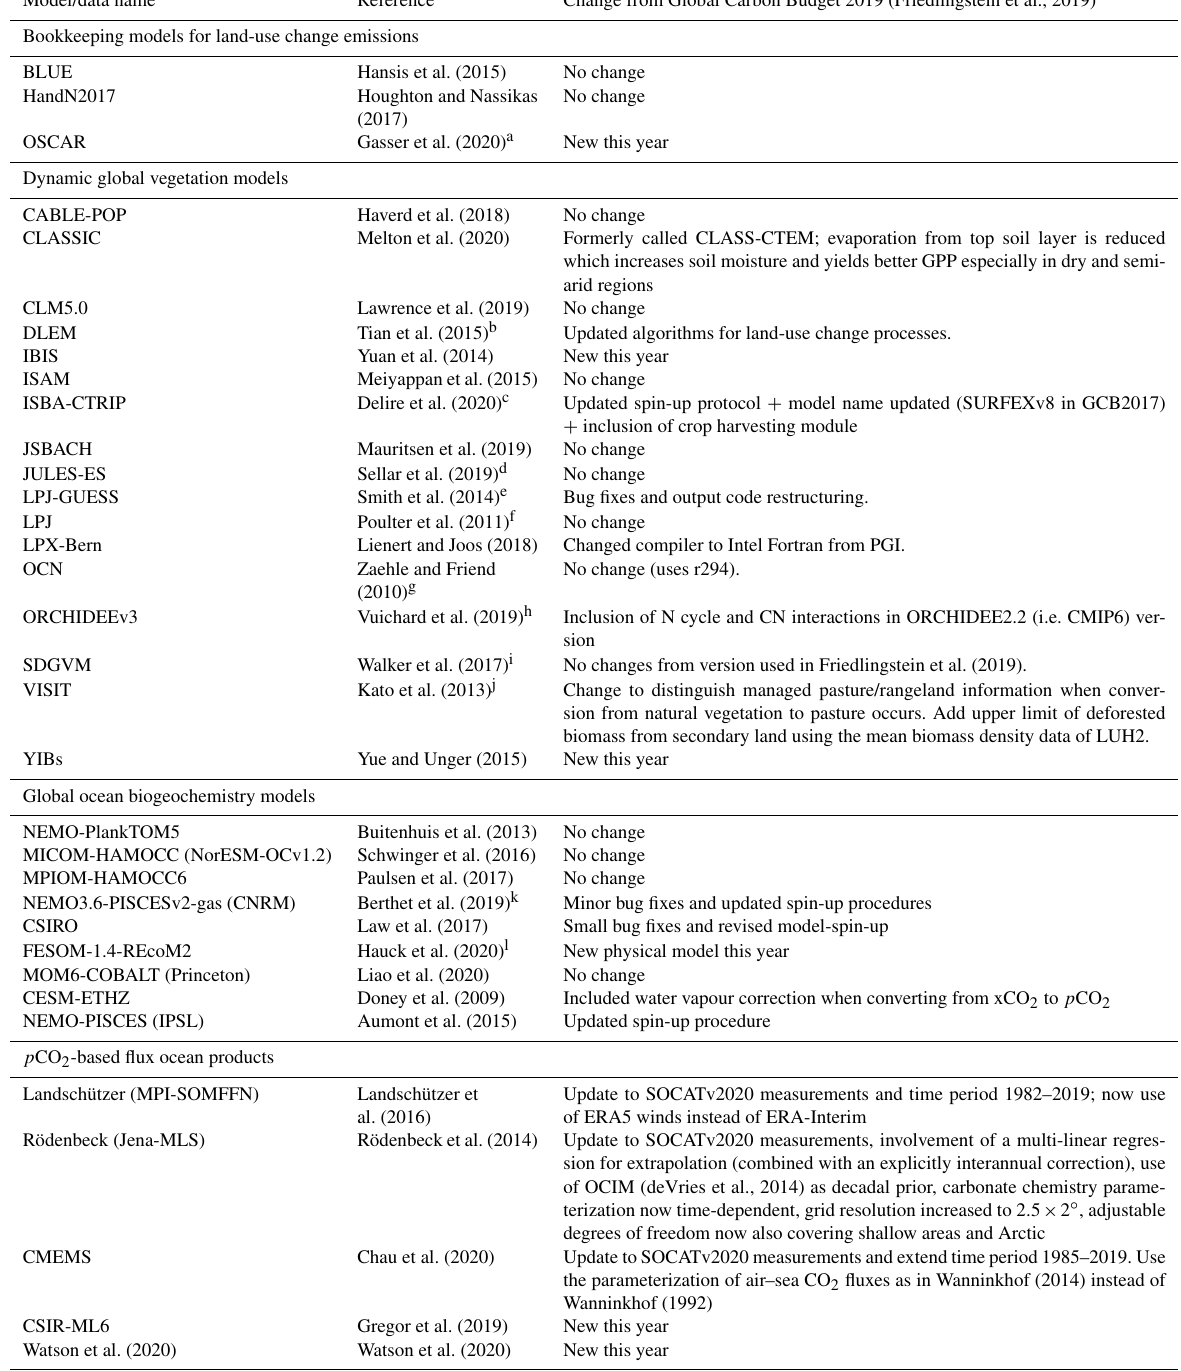
Table 4. References for the process models, p CO 2 -based ocean flux products, and atmospheric inversions included in Figs. 6–8. All models and products are updated with new data to the end of the year 2019, and the atmospheric forcing for the DGVMs has been updated as described in Sect.